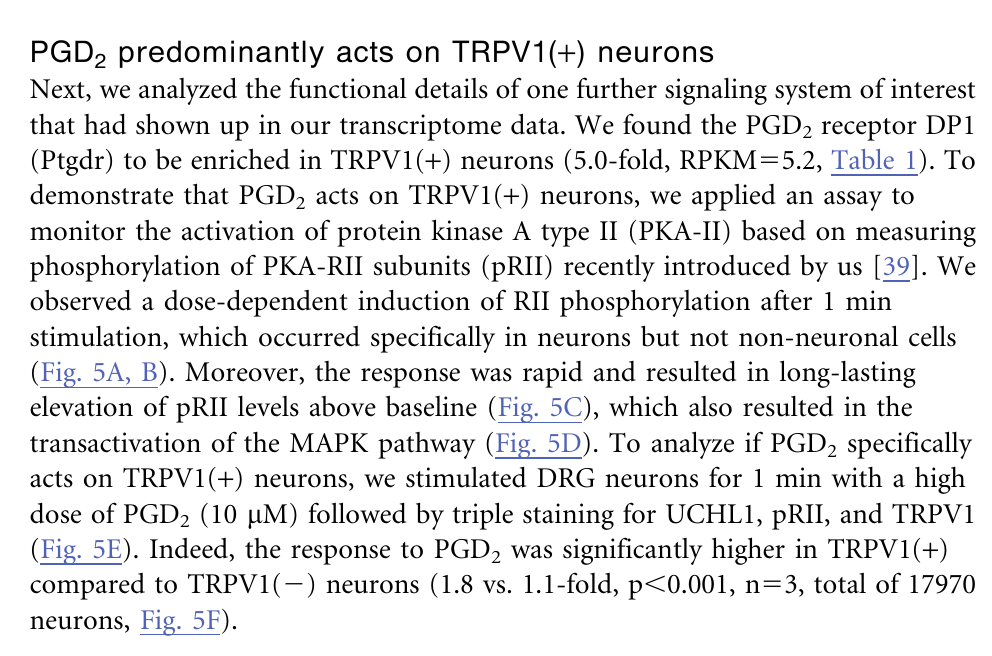
Fig. 4. Validation of the transcriptome data by single cell based quantitative High Content Screening (HCS) microscopy focusing on selected signaling-relevant proteins. (A) Triple staining of the neuronal marker UCHL1 and two different TRPV1 antibodies derived from rabbit and goat, respectively, to facilitate the analysis of various targets. The staining intensities obtained with both TRPV1 antibodies correlated significantly (Spearmans r 5 0.96, p , 2.2e-16). (B-E, G) Co-labeling of TRPV1 and CART (B), Nos1 (C), KChIP1 (D), KChIP2 (E), and CaMKII a (G). Plots of respective controls are shown in S1 Fig. (F) Average fluorescence intensities of TRPV1 and the indicated targets in TRPV1-negative (grey) and -positive (black) neurons. Signal intensities of all analyzed targets were significantly higher within the TRPV1( + ) population (n 5 3 with . 3000 analyzed neurons per experiment, paired two- tailed